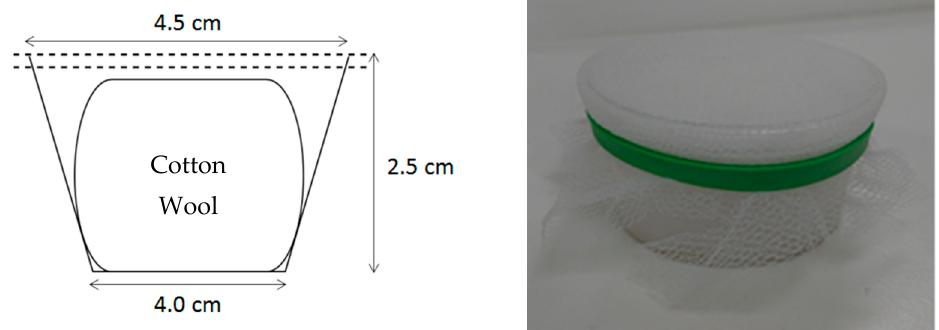
Figure 1. Sugar feeder made from a plastic pot of 2.5 cm height, large radius of 4.5 cm, and small radius of 4 cm. A wad of cotton wool was pressed into the pot to be just below the upper lip without touching the netting (judged by eye) and soaked in sugar solution into which the required concentration of insecticide was dissolved. A double layer of netting was stretched across the top and secured using an elastic band.